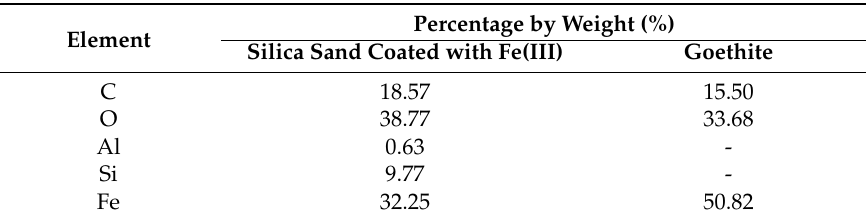
Table 3. Elemental analysis of